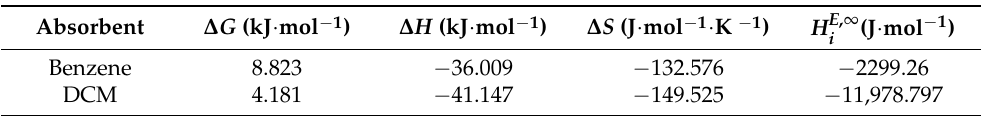
Table 5. Gibbs energy, enthalpy, entropy, and partial molar excess enthalpy of absorption for DCM and benzene in [HMIM][Cl] at 303.15